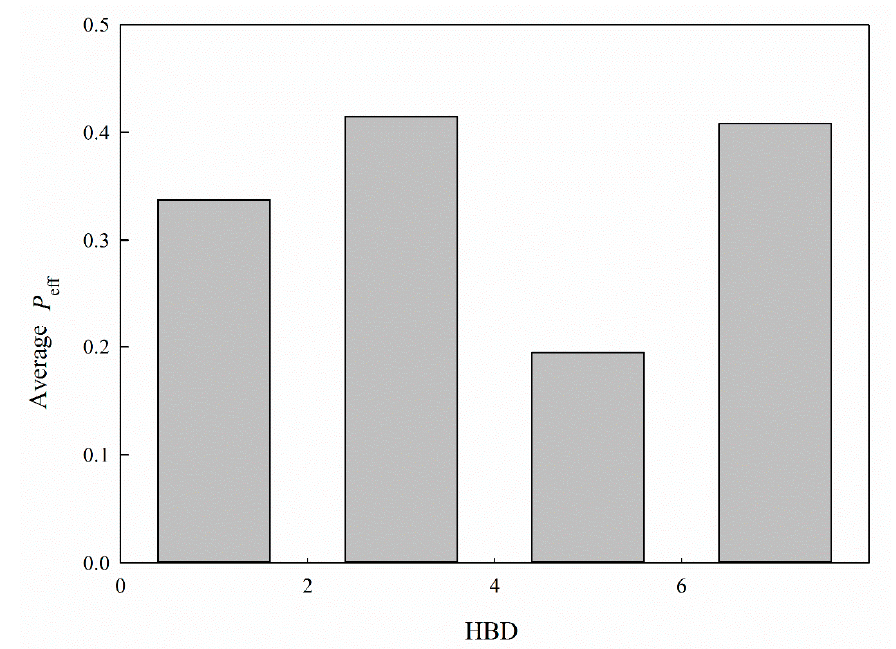
Figure 8. Average P eff vs. the distribution of HBD.